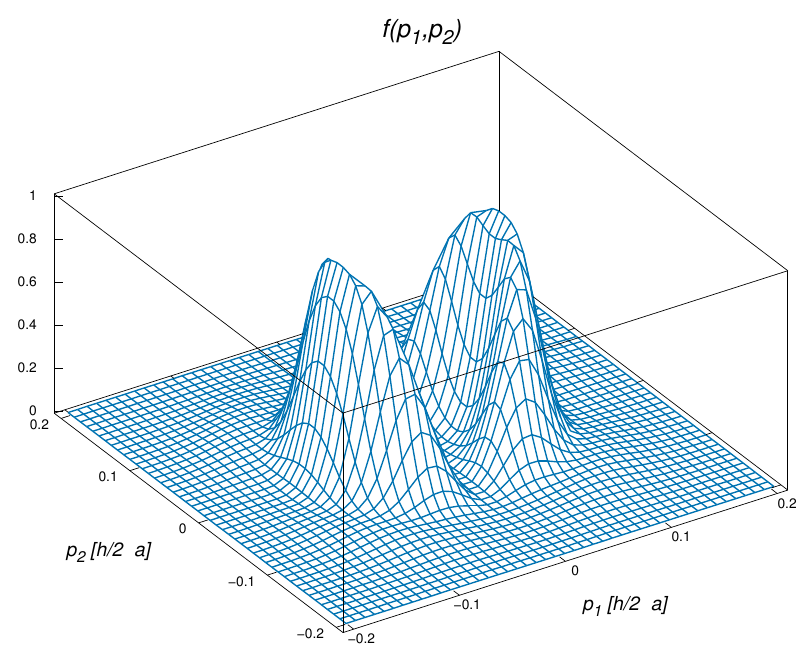
Figure 3. Distribution function f ( k , t → ∞ ) after the end of the pulse calculated on the basis of kinetic equations (KEs) (27). The values of the momentum components are given in units of [ ¯ h / a ].